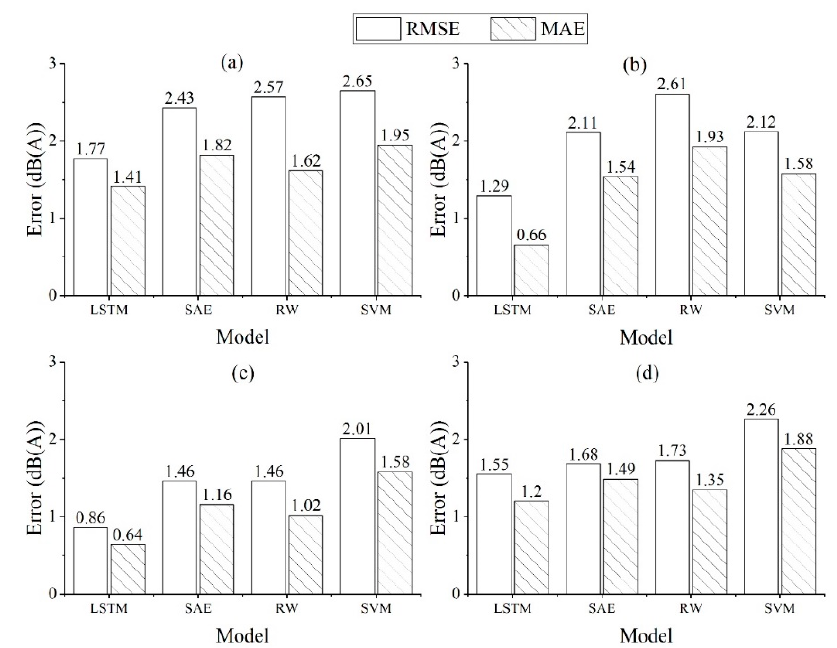
Figure 8. Comparison of prediction results of di ff erent models at di ff erent time intervals: ( a ) 1-s interval; ( b ) 1-min interval; ( c ) 10-min interval; ( d ) 30-min interval.